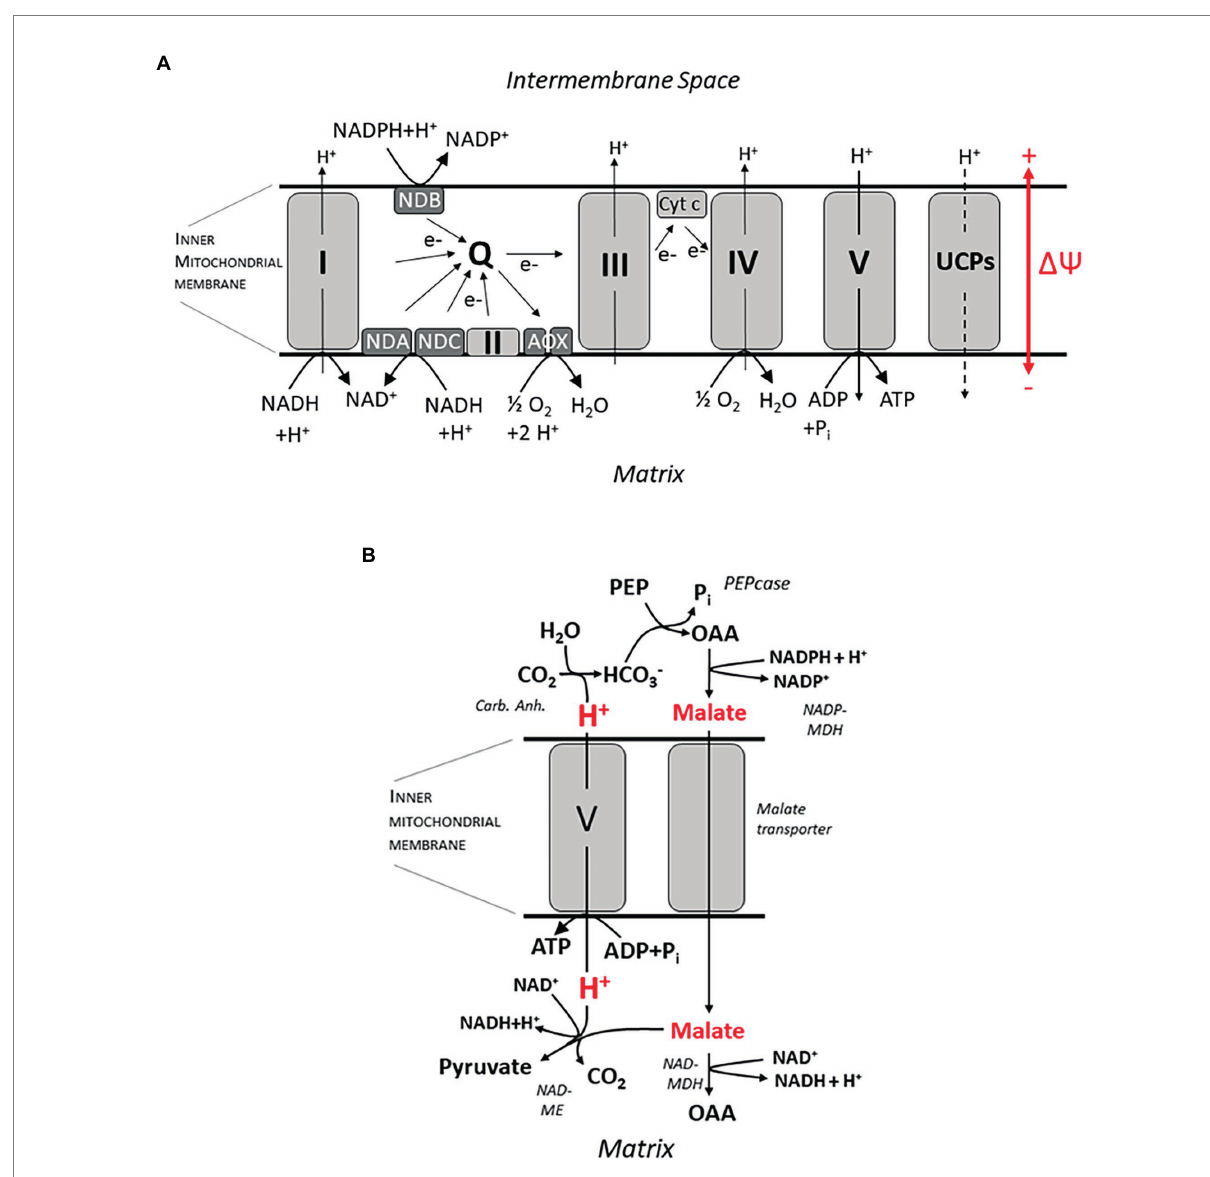
FIGURE 2 ATP synthesis at the inner mitochondrial membrane. In (A) an overview on the electron transport chain is given, including complexes I–V, NAD(P)H dehydrogenases (ND) A, B and C and the alternative oxidases (AOX). Q, ubichinone pool; UCPs, uncoupling proteins; and ΔΨ , membrane potential. A putative mechanism for ATP synthesis which does not involve circular H + flow is shown in (B) . H + is released by formation of HCO 3 -catalyzed by the (Carb. Anh.) reaction. HCO 3 -is subsequently assimilated by the Phosphoenolpyruvate-Carboxylase (PEPcase) synthesizing Oxaloacetate (OAA) from Phosphoenolpyruvate (PEP). Subsequently malate is formed by the NADPH-dependent Malate-Dehydrogenase (NADP-MDH), and malate passes through a yet unidentified transporter into the mitochondrial matrix. Subsequently, it can either be oxidized again to oxaloacetate by the